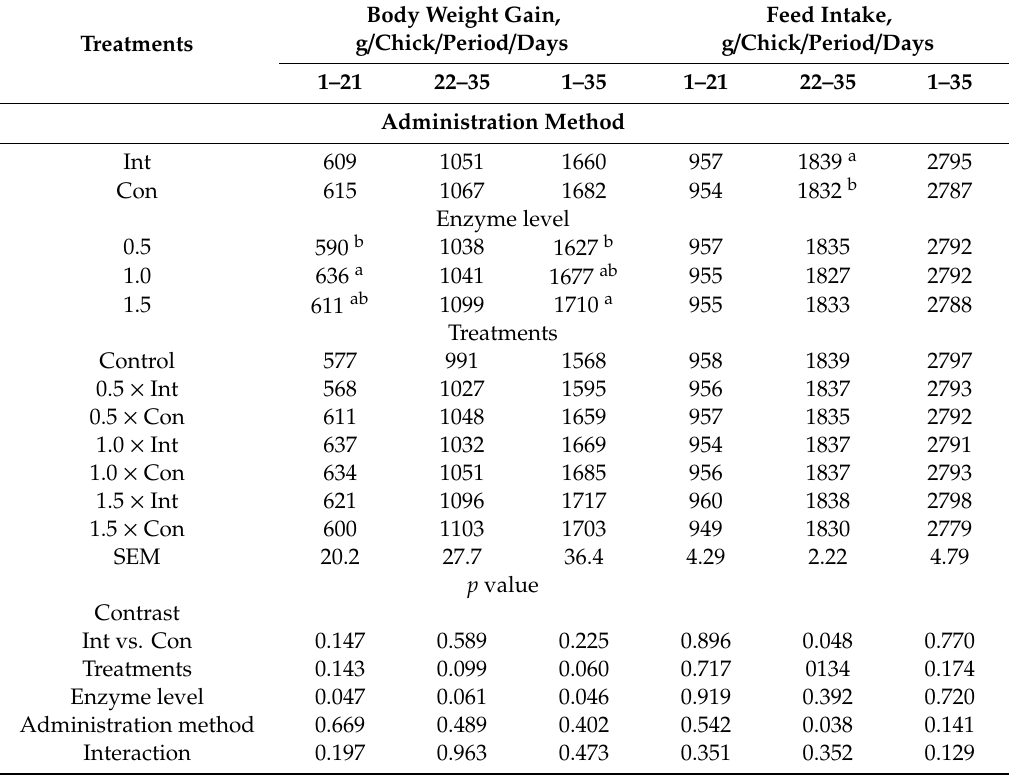
Table 2. E ff ects of multienzymes supplemented continuously or intermittently on body weight gain and feed intake of Arbor Acres broiler chicks during 1–35 days of